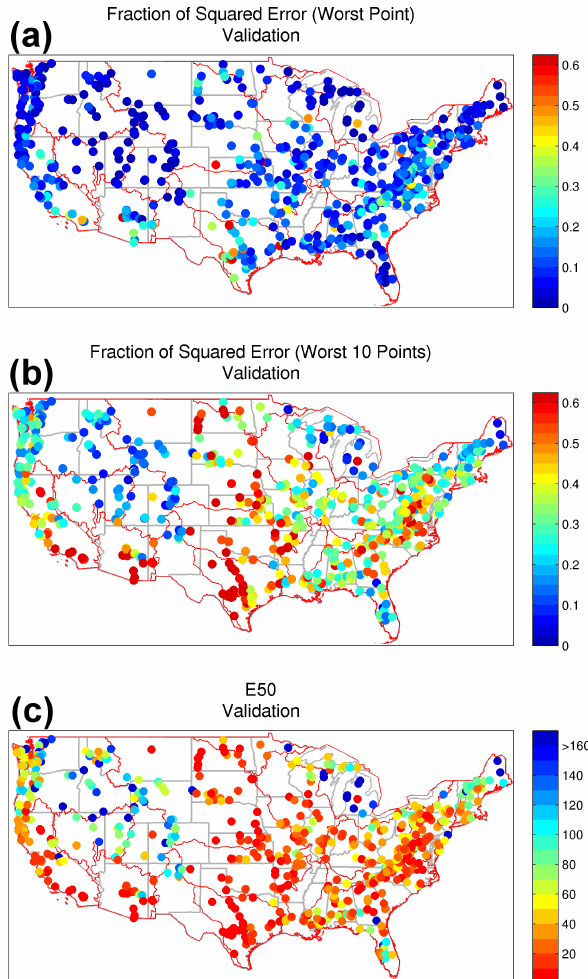
Figure 11. (a) Spatial distribution of the fractional contribution of total squared error for the largest day during the validation period, the (b) 10 largest error days, and (c) the number of days contributing 50% of the total objective function error,